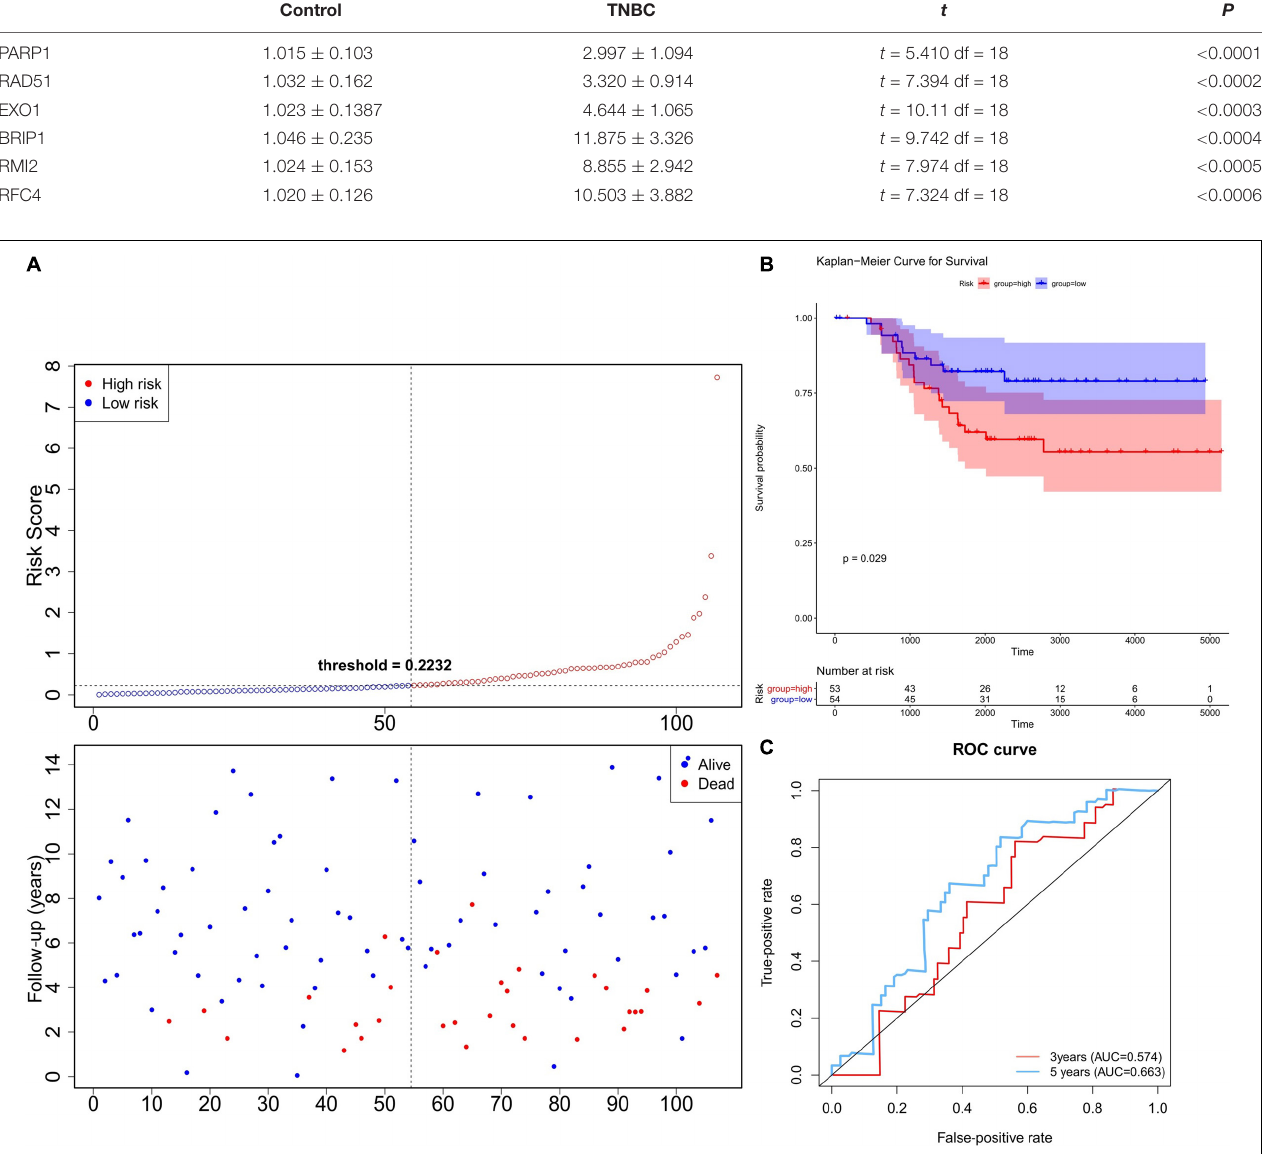
FIGURE 4 | Validation of the six-gene prognostic model using the GEO database. (A) The Risk curve of the risk model. The risk value of patients increases from left to right. According to the median value, the samples were divided into high- and low-risk groups. (B) K–M survival curve of verification set—Risk score. The ordinate indicates survival rate, and the abscissa indicates total survival time. The red curve represents the high-risk group, and the blue curve represents the low-risk group. The difference between high- and low-risk groups was significant (0.0012). (C) Validation Set—ROC Curve to evaluate the effectiveness of the risk